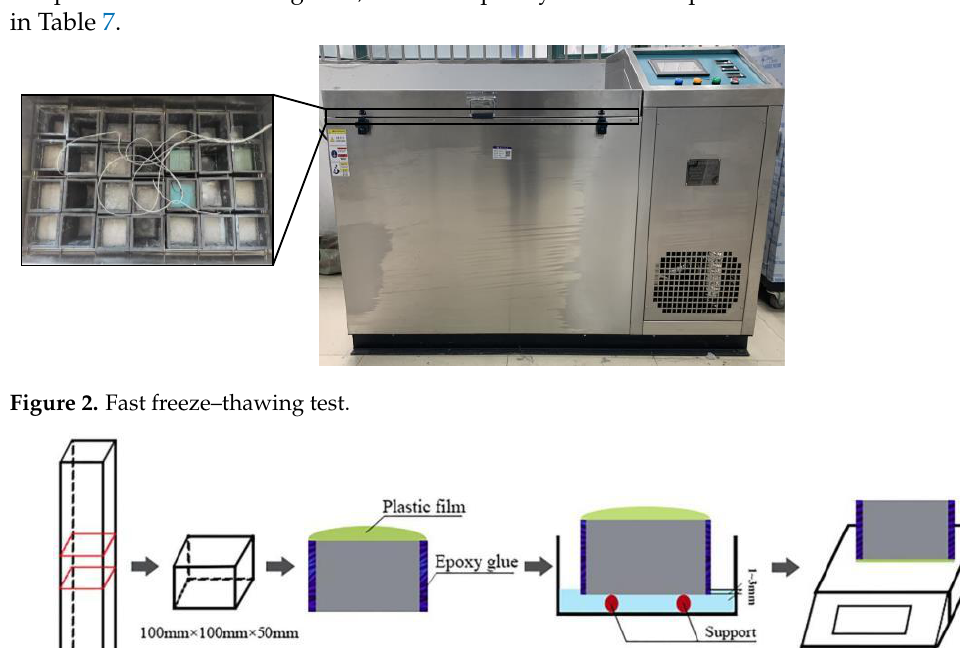
Figure 2. Fast freeze – thawing test.